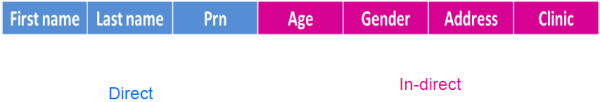
Classification of personal health information (PHI).